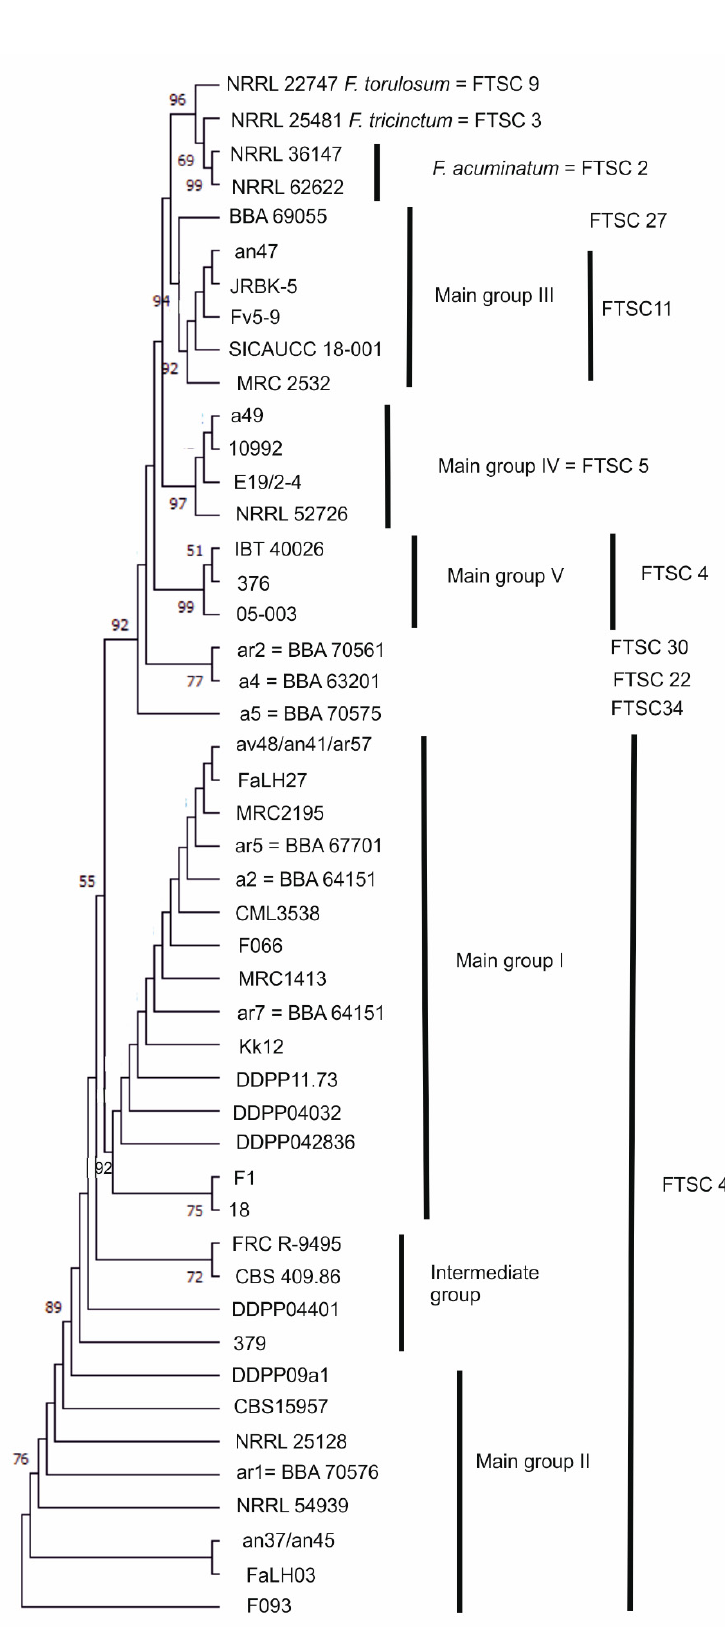
Figure 1. Maximum-parsimony consensus tree of translation elongation factor 1-alpha ( TEF1 ) se- quences. Bootstrap values are indicated above nodes based on 500 pseudoreplicates of the data. Only branches present in more than 50% of the trees are shown. Fusarium tricinctum and F. acumina- tum strains are outgroups.